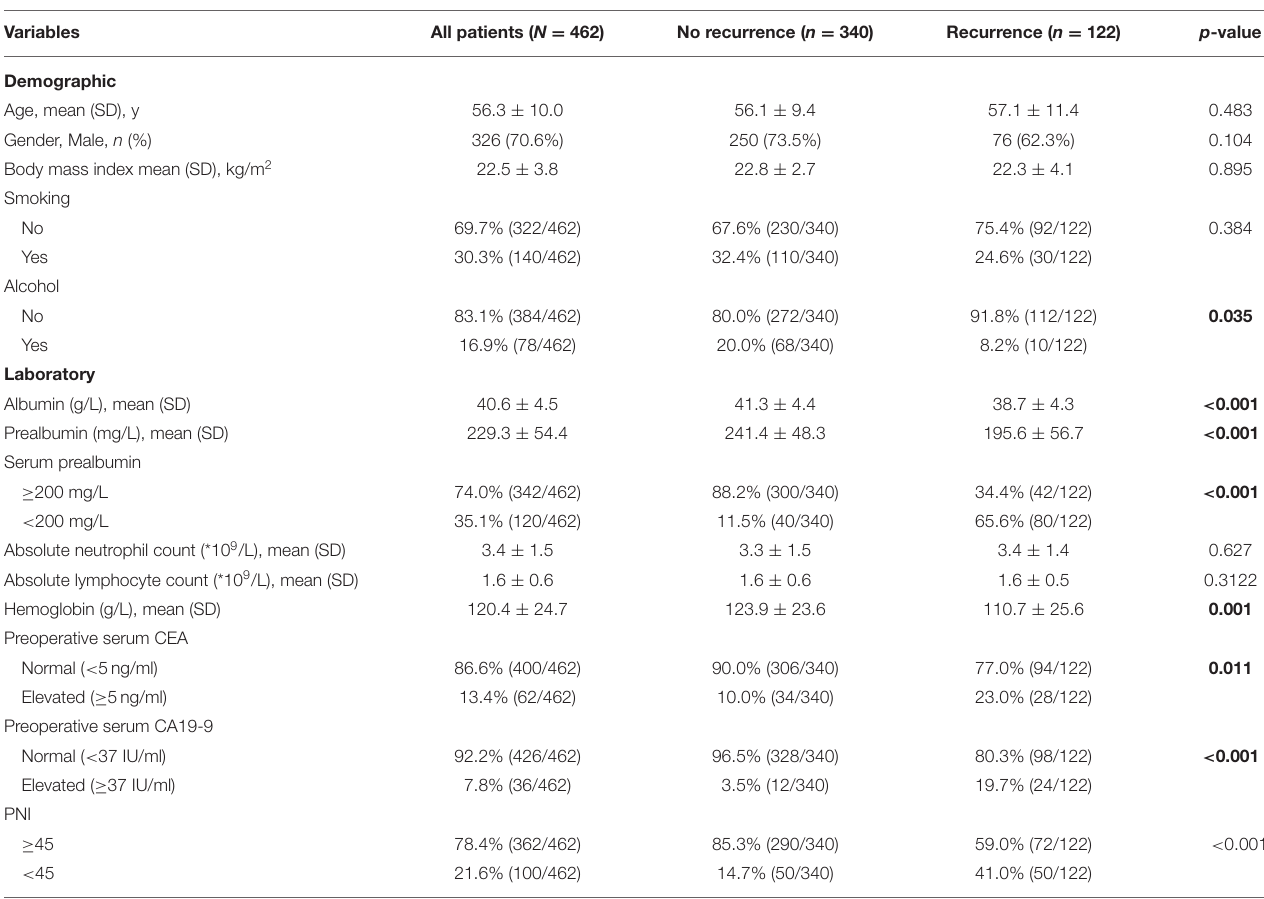
TABLE 1 | The demographic and laboratory characteristics of all patients ( n =